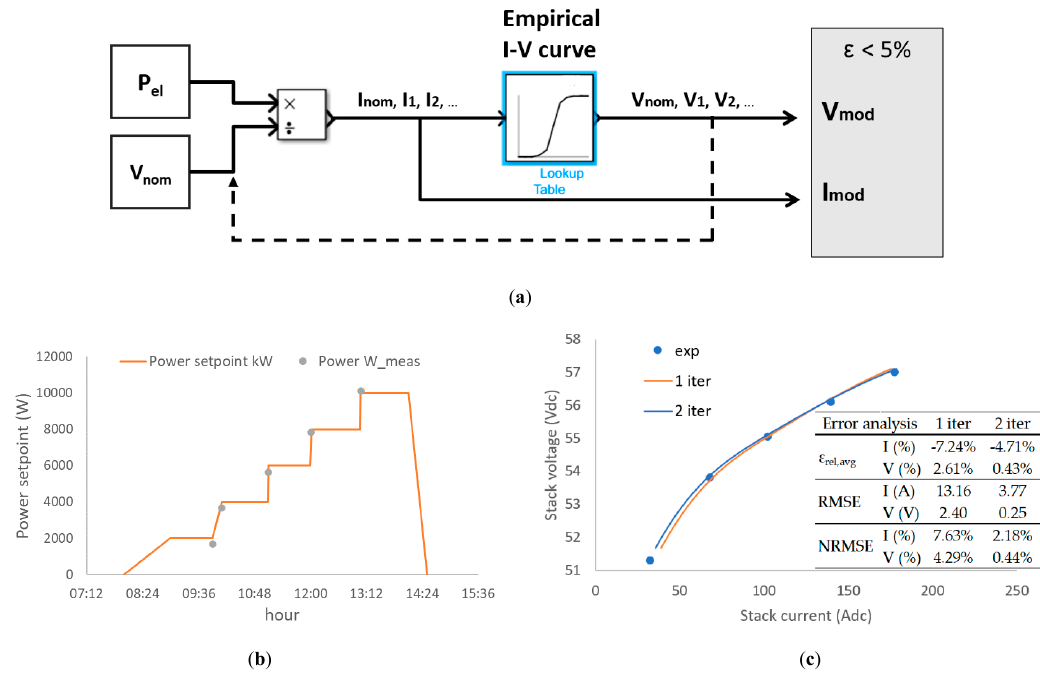
Figure 8. ( a ) Alkaline electrolyzer empirical modelling scheme; ( b ) experimental test procedure Figure 8. (a) Alkaline electrolyzer empirical modelling scheme; (b) experimental test procedure (c) polarization curve (stack) experimental data, polynomial fitting and error analysis. ( c ) polarization curve (stack) experimental data, polynomial fitting and error